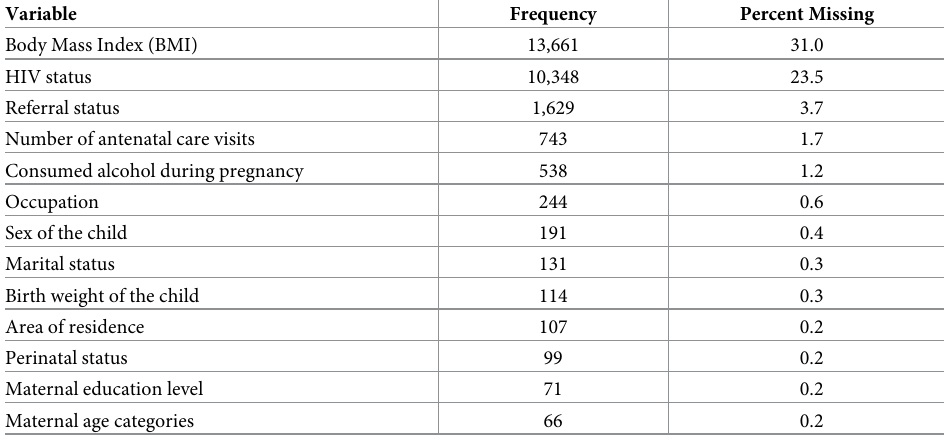
Table 3. Distribution of missing values, KCMC medical birth registry, 2000–2015 (N =